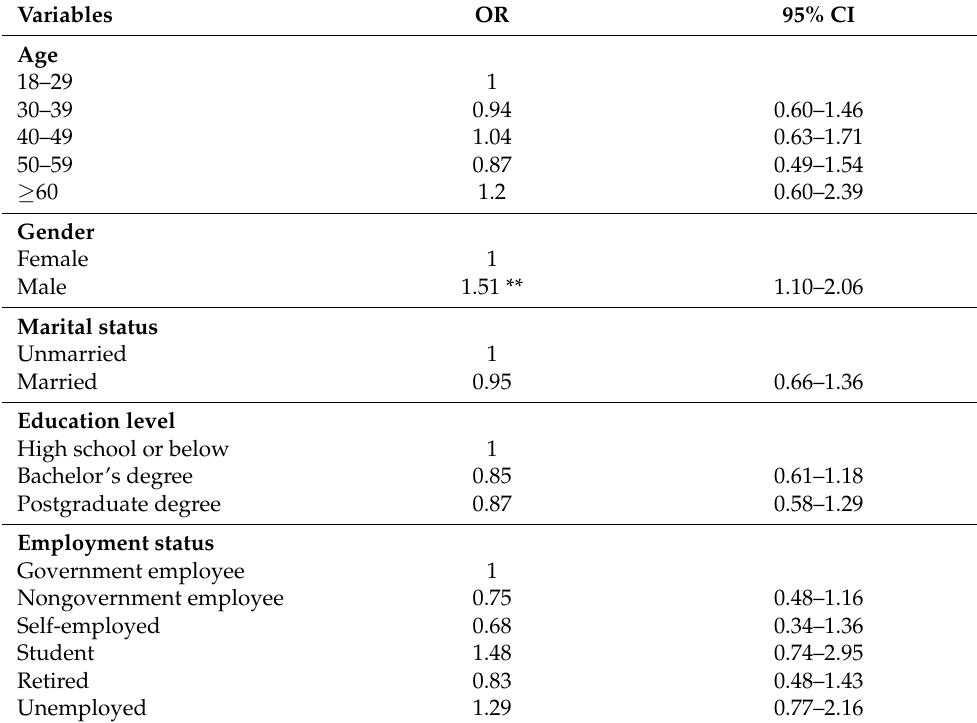
Table 2. Logistic regression estimates of factors associated with COVID-19 vaccine acceptance. OR, odds ratio; CI, confidence